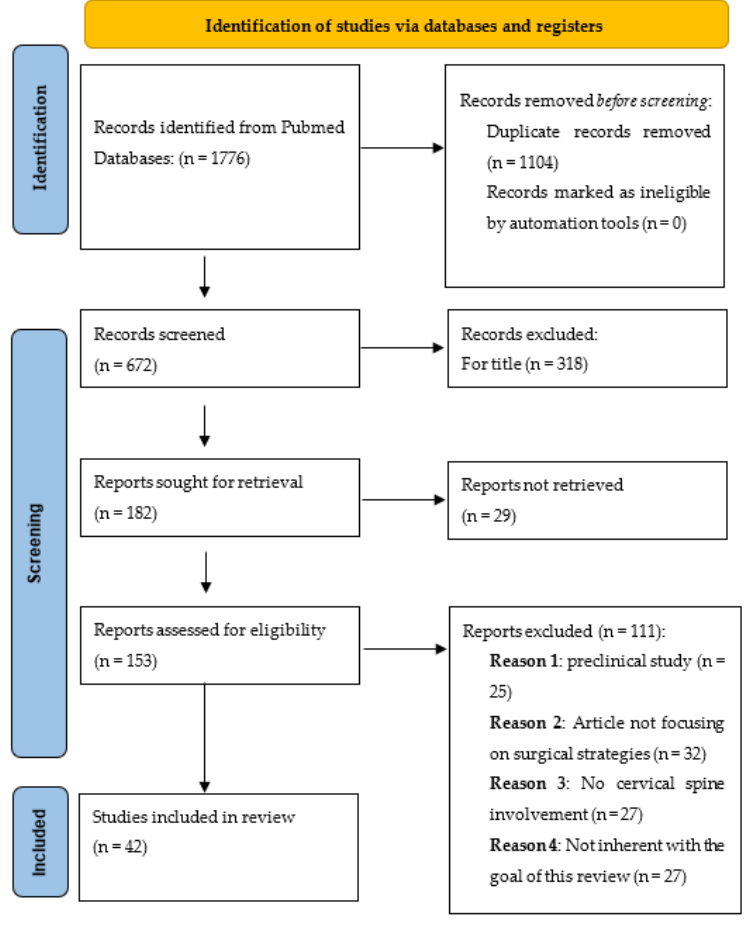
Figure 1. PRISMA flow diagram .